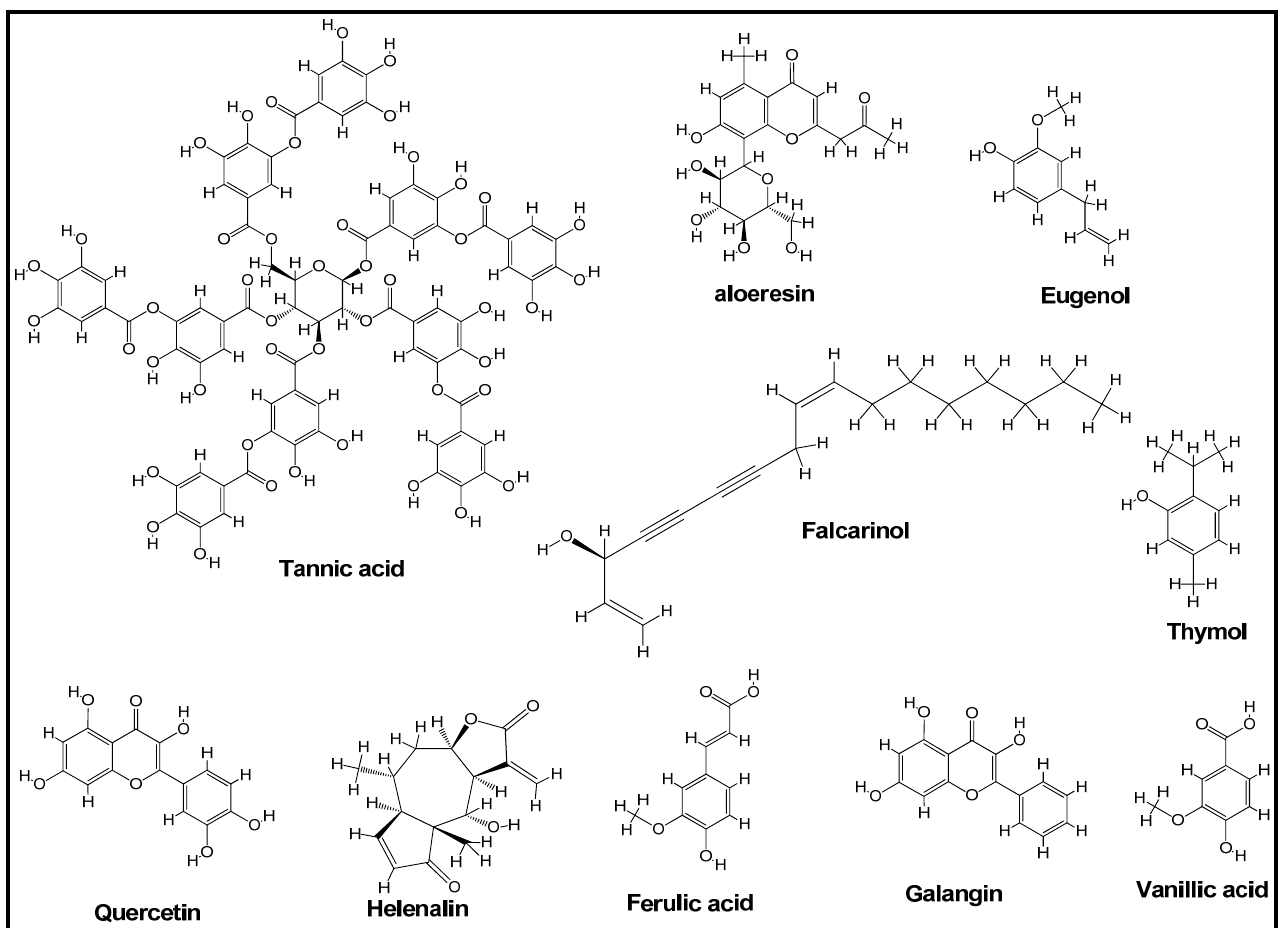
Figure 4. Structures of some examples of secondary metabolites in plant.